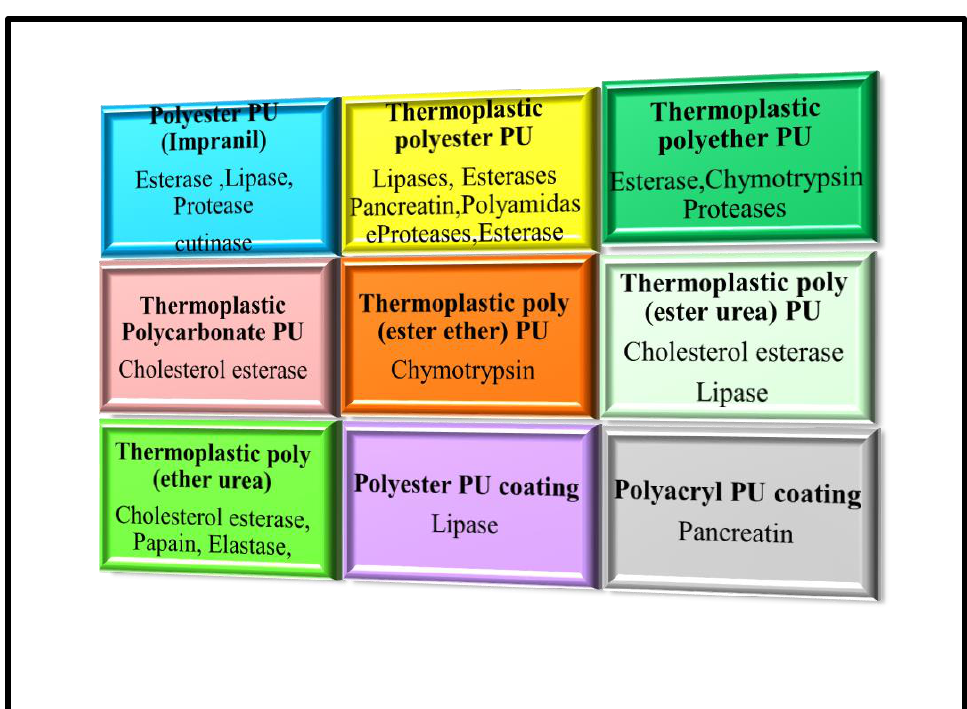
Figure 16. Degradation of Different Polyurethanes by Various Enzymes.